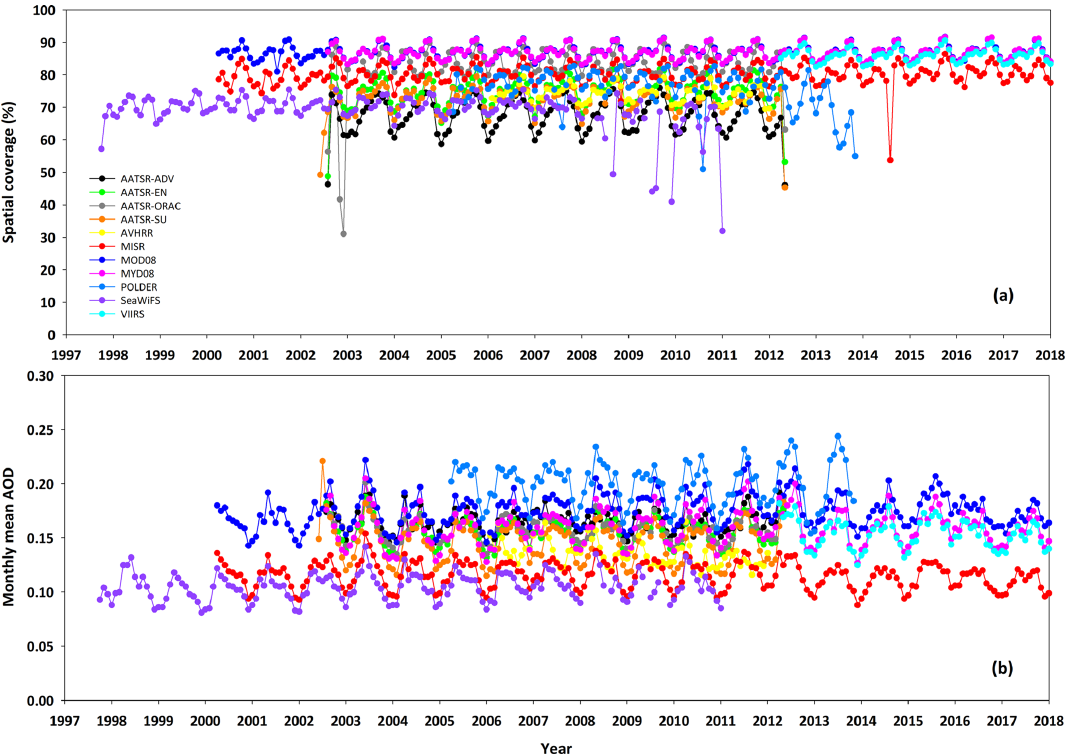
Figure 8. Time series of global spatial coverage and mean value of satellite-derived monthly aerosol products for their respective available periods from 1997 to 2017. Table 3. Seasonal statistics of spatial coverage and global means of satellite-derived AOD S from 2006 to 2010.